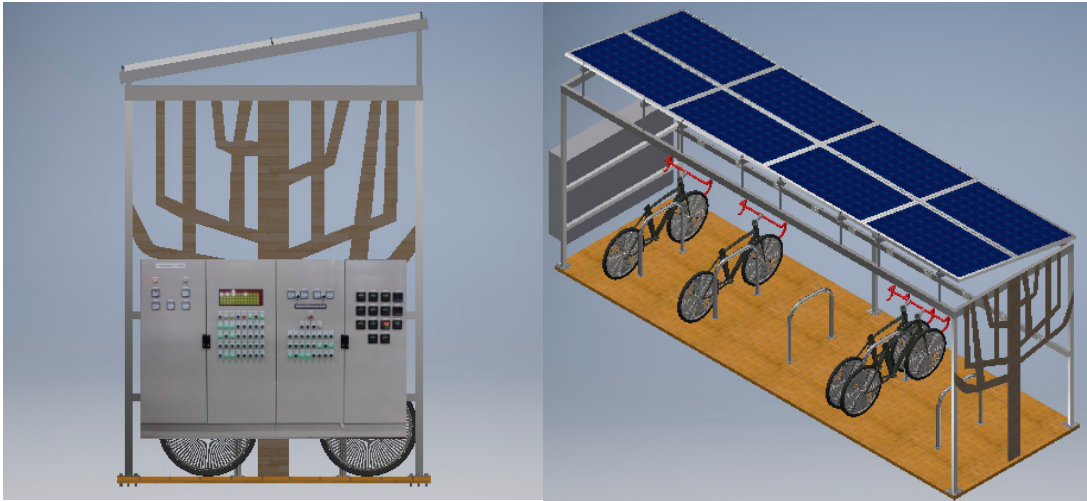
Figure 9. BiCiSOLAR charging station renders at Sergio Arboleda University.